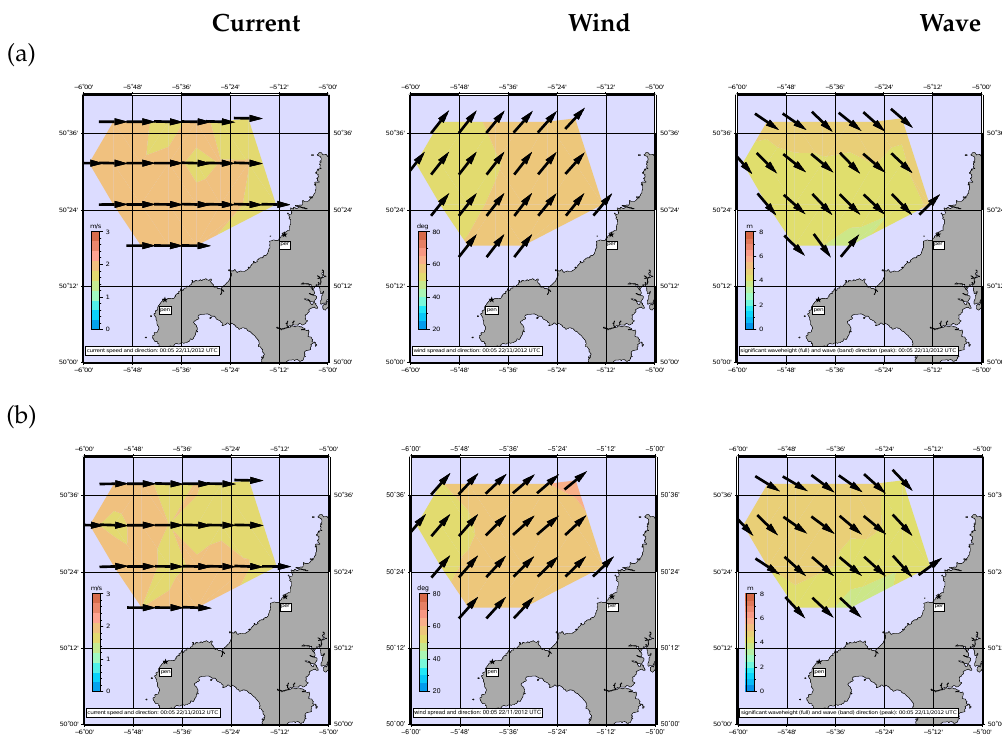
Figure 12. Inverted data for case 2. ( a ) monostatic ( b ) 1 bistatic.